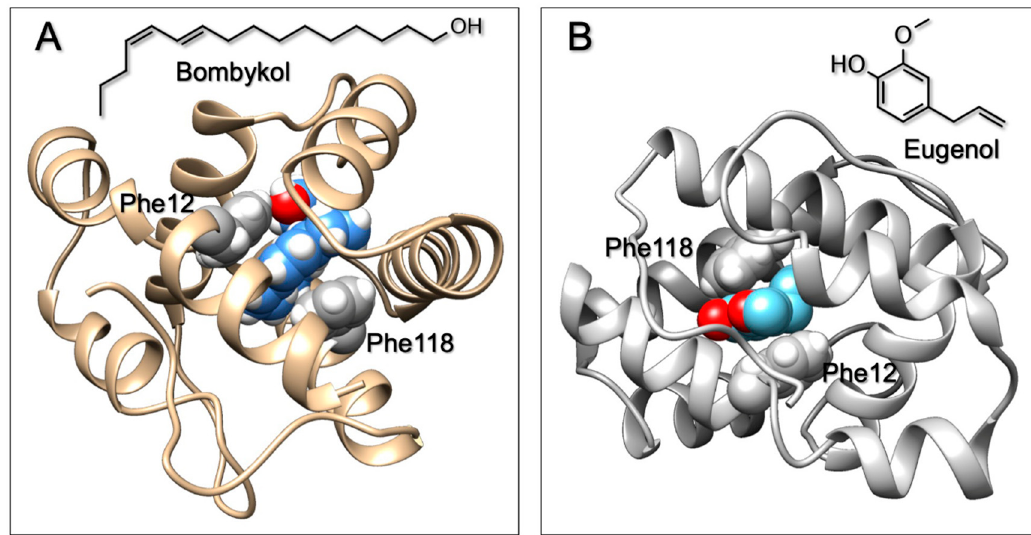
Figure 4. Docking simulations of the binding of bombykol ( A ) and eugenol ( B ) to the PBP1 of B. mori . In both cases, the molecule is sandwiched between two phenylalanine residues, Phe12 and Phe118. Good π − π interactions are established between the benzene rings of these two residues and the conjugated system of bombykol or the aromatic ring of eugenol. Docking simulation was performed using the online software Swiss Dock [40].